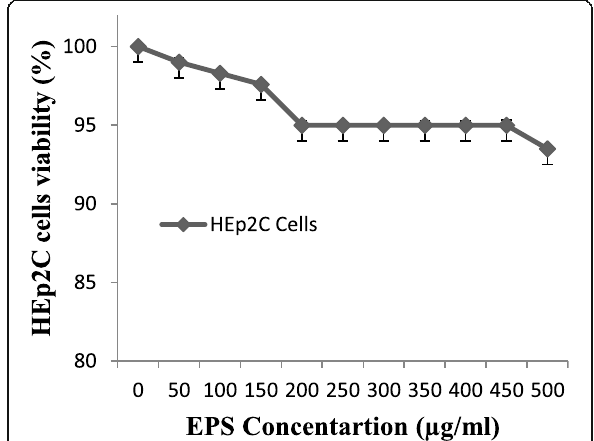
Fig. 8 HEp-2C was expressed by the percentage of cell viability after 24h exposure to each purified EPS concentration of L. paraplantarum